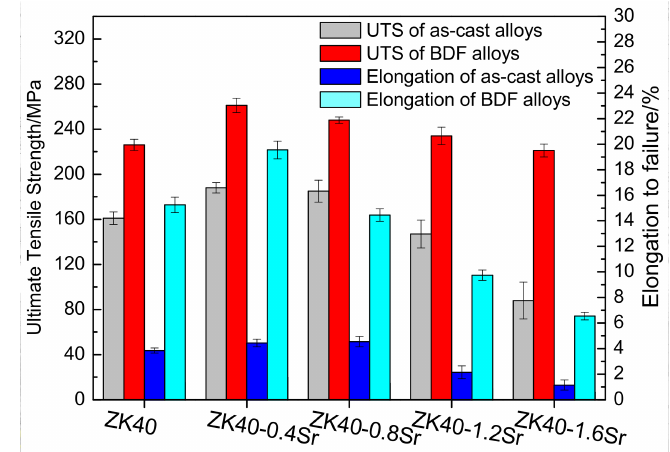
Figure 6. Comparison of the ultimate tensile strength (UTS) and elongation to failure ( ε ) of the as-cast and BDF ZK40-xSr alloys in